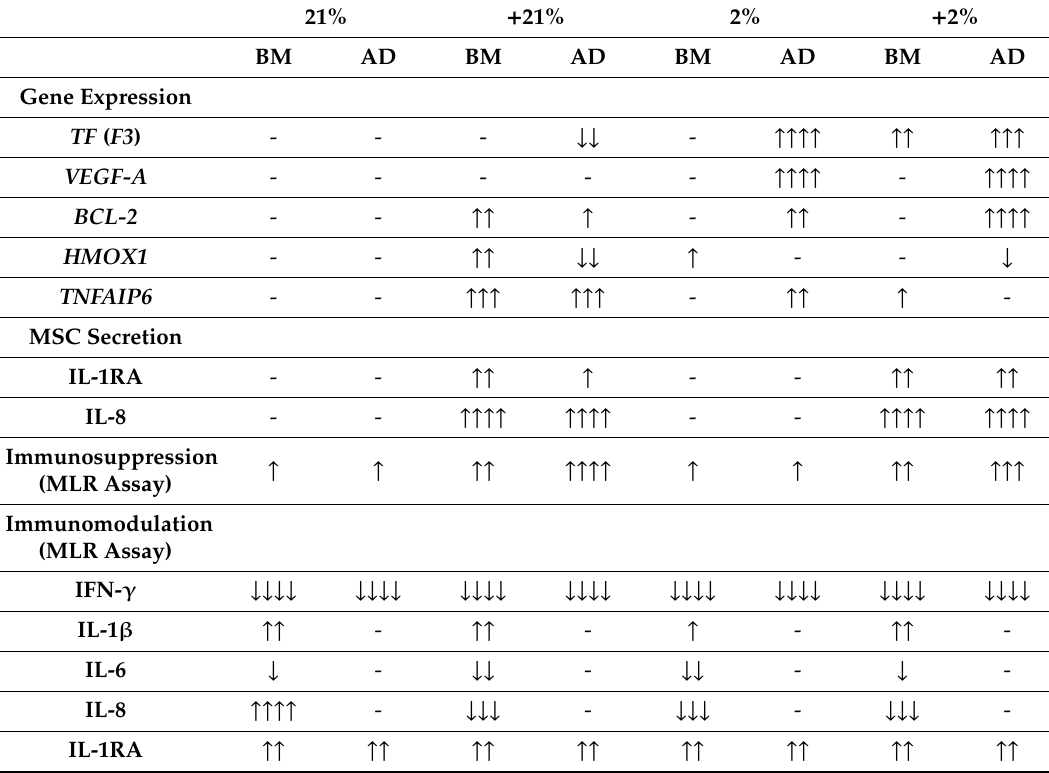
Table 1. Semi-quantitative summary of results. ↑ and ↓ denote increases and decreases,